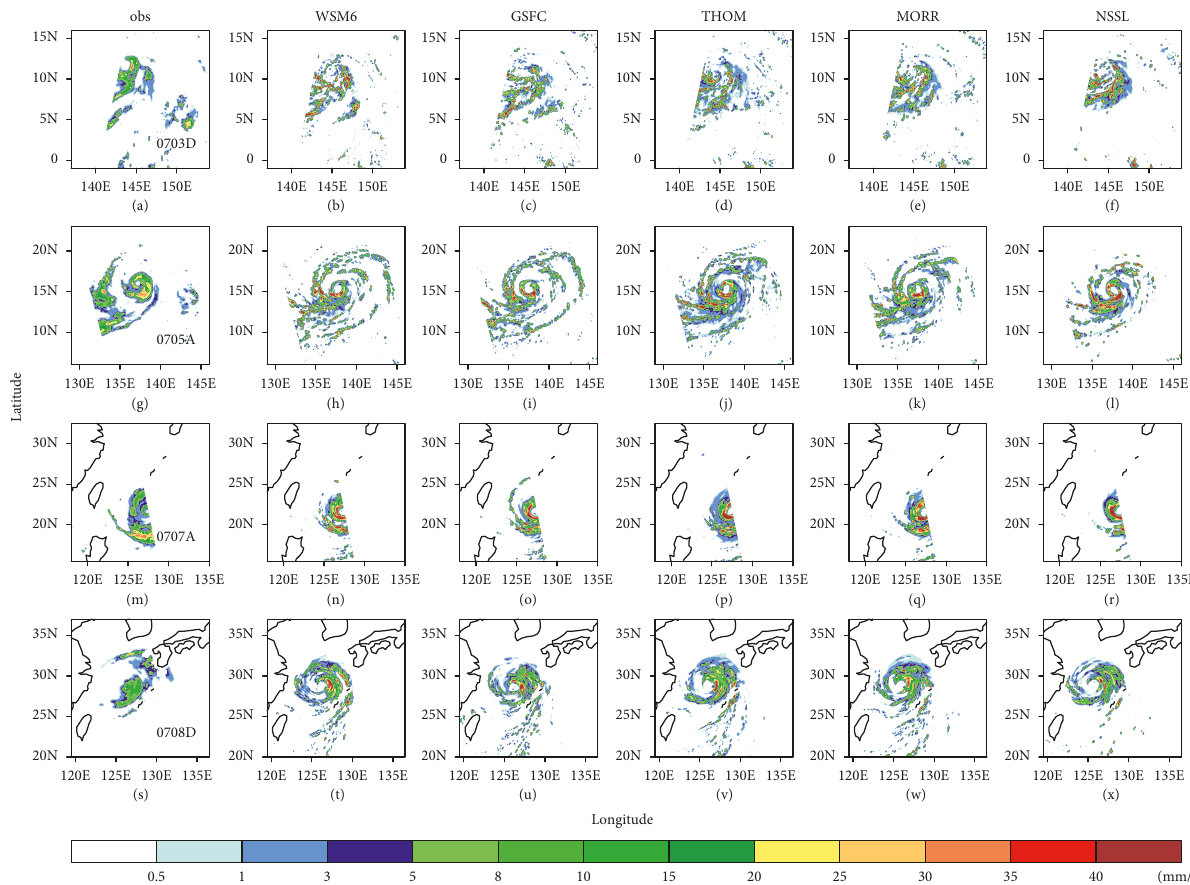
Figure 4: Horizontal distribution of FY-3B-MWRI (first column) retrieved and model-simulated surface precipitation rate (mm/h) produced with the supertyphoon Neoguri, using the cloud microphysical schemes of WSM6 (second column), GSFC (third column), THOM (fourth column), MORR (fifth column), and NSSL (sixth column). Note that the first to fourth rows correspond to the time of FY-3B overpasses of 0703D, 0705A, 0707A, and 0708D.